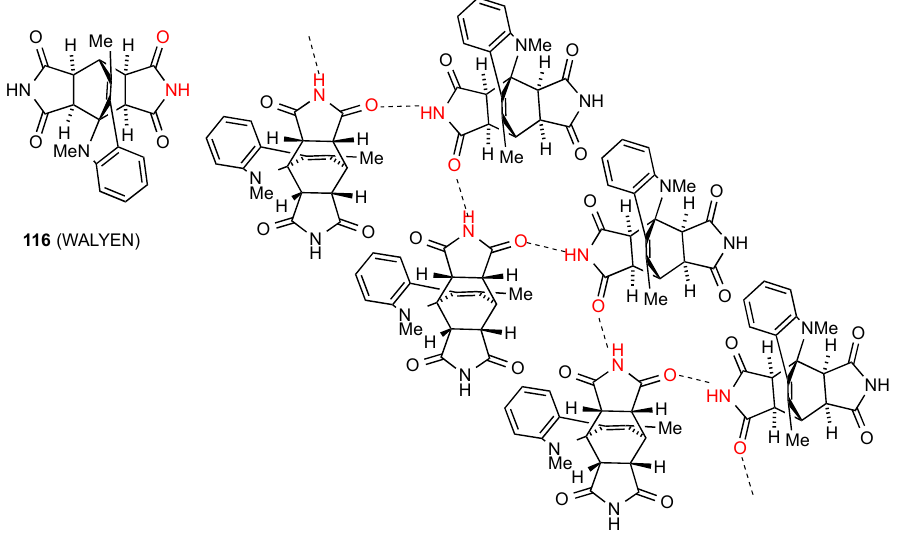
Figure 42. Structure adopted by compound 117. The final structure, compound 118 [112] (Figure 43) exists as imide NH to sulfonyl SO R 2 2 (16) dimers that are further cross-linked to each other by an R 2 2 (12) interaction of sulfonamide NH and an imide CO in the same unit, thus setting up also two R 2 2 (8) units.